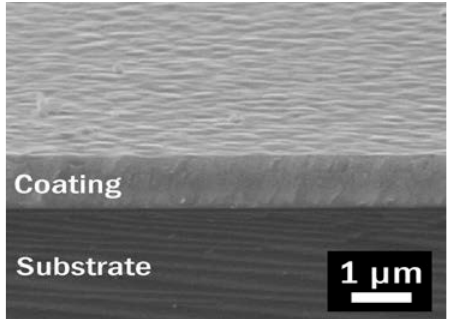
Figure 2. Typical cross section of Cr x C y coating grown on silicon substrate placed on the substrate holder inside a quartz tube 30 cm long, 24 mm internal diameter (ID) (450 °C, 7 × 10 3 Pa, 500 sccm N 2 ,